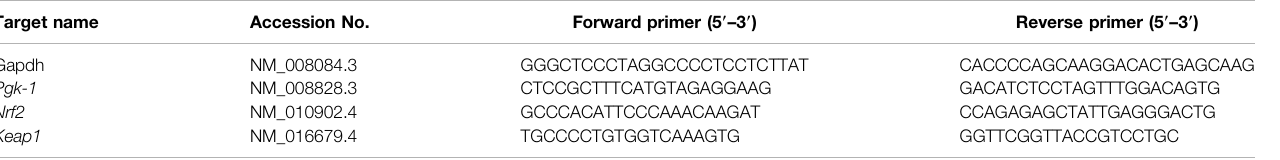
TABLE 1 | Gene-Speci fi c Primer Sequences Used for qPCR. Target